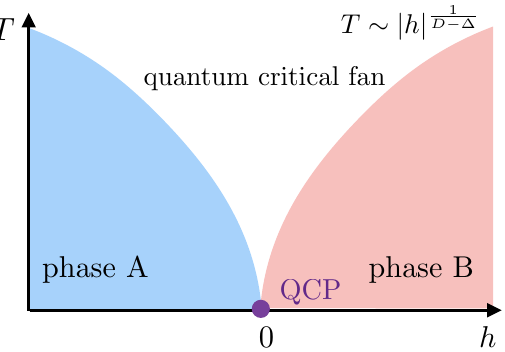
Figure 1 . Schematic phase diagram of a theory with a (conformal) quantum critical point sep- arating two phases at zero temperature. The non-thermal detuning parameter h must be set to zero at the critical point. At (cid:12)nite temperature T , when T & in between the two phases where the system behaves qualitatively like the quantum critical point h = 0, detuned only by temperature. In this paper, we demonstrate that certain (cid:12)ngerprints